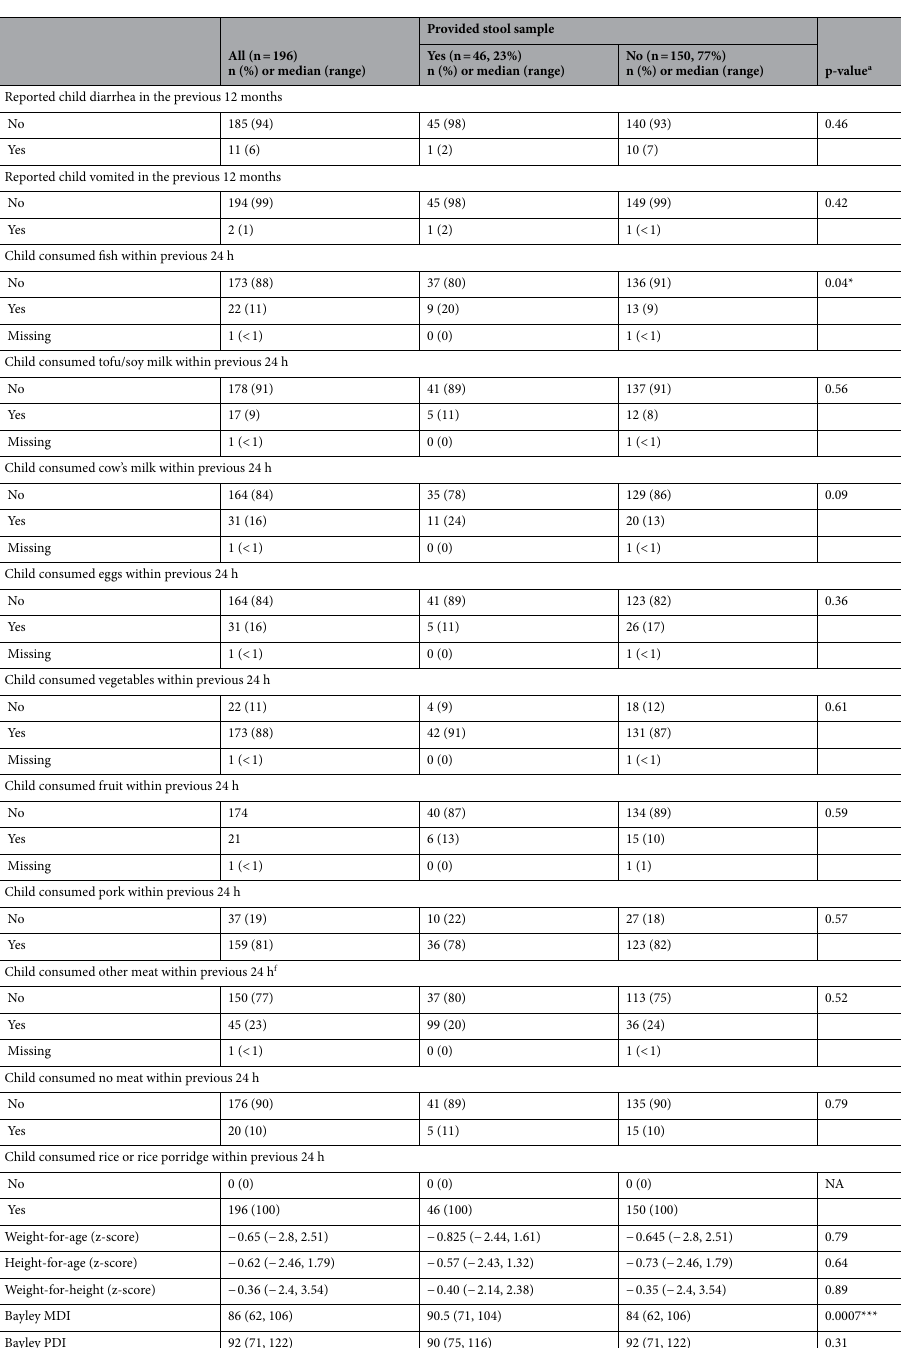
Table 1. Comparison of maternal/child characteristics between children who provided a stool sample and those who did not among 196 children with Bayley testing at 36 months. a P-values are for comparisons between participants providing a stool sample, and those that did not. For categorical variables, p-values are for chi-squared test or Fisher’s exact test between non-missing categories, and for continuous variables, p-values are for the Wilcoxon rank sum test: *p < 0.05, **p < 0.01, ***p < 0.001. b BMI for Asian populations: underweight (BMI < 18.5 kg/m 2 ), normal weight (18.5 kg/m 2 ≤ BMI < 23 kg/m 2 ), overweight (23 kg/m 2 ≤ BMI < 27.5 kg/m 2 ), and obese (BMI ≥ 27.5 kg/m 2 ) 54 . c Workers include: civil servant, white-collar worker, skilled worker, unskilled worker, and shopkeeper. d Median breastfeeding duration based on 12-month and 36-month responses (n = 332 mothers). e Illnesses and symptoms queried included upper respiratory illness, lower respiratory illness, difficulty breathing, diarrhea, vomiting, fever, and rash. Children who donated a stool sample did not have any reported rash or difficulty breathing. f Other meat includes sheep, beef, chicken, or duck. BMI body mass intake, MDI Mental Developmental Index, PDI Psychomotor Developmental Index, RMB ren min bi = Chinese